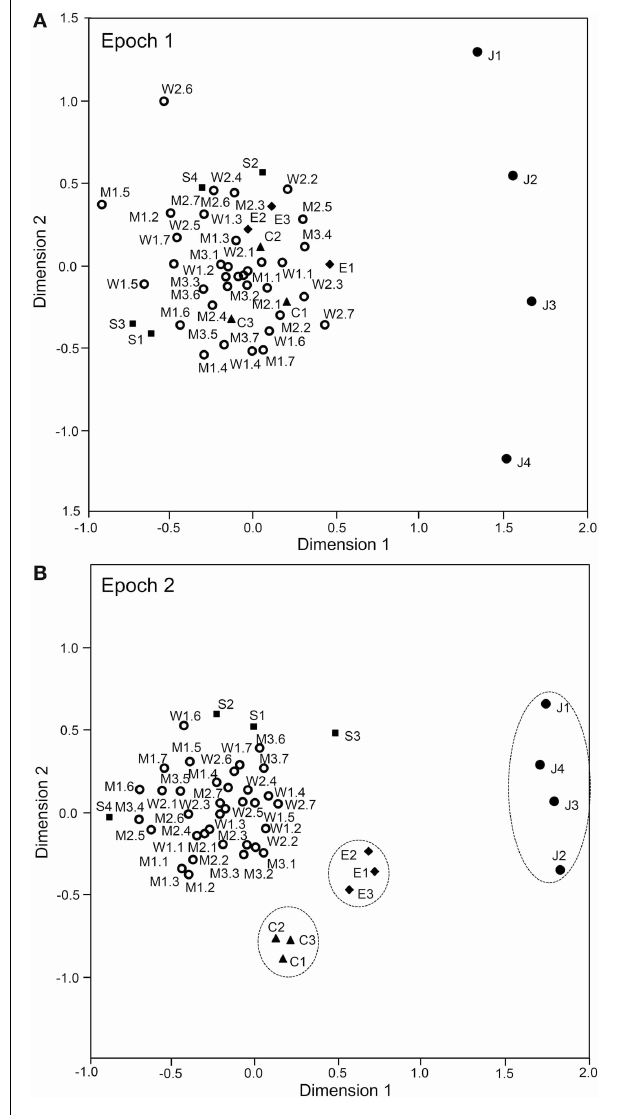
FIGURE 9 | Distributions of the 49 visual stimuli in the two-dimensional space resulting from multidimensional scaling in epoch 1 (A) and epoch 2 (B). In epoch 1 (A) , 1 cluster that includes stimuli other than the face-like patterns (J1–4) was recognized. The face-like-patterns were located separately from this big cluster. In epoch 2 (B) , the following four groups were recognized: 1 large group that consisted of various stimuli, including the facial photos and simple geometric patterns, and three small groups corresponding to the face-like patterns, cartoon faces, and eye-like patterns. C1–3, three cartoon faces; J1–4, four face-like patterns; E1–3, three eye-like patterns; S1–4, simple geometric patterns; W1–2, female models; M1–3, male models. The numbers from 1 to 7 after the model numbers and colons indicate the head orientations and the gaze directions indicated in Figure 1A .